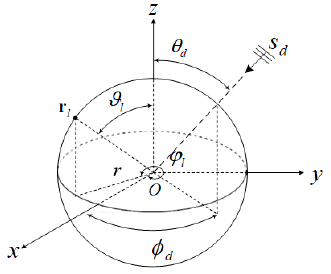
Figure 1. Spherical coordinate system .